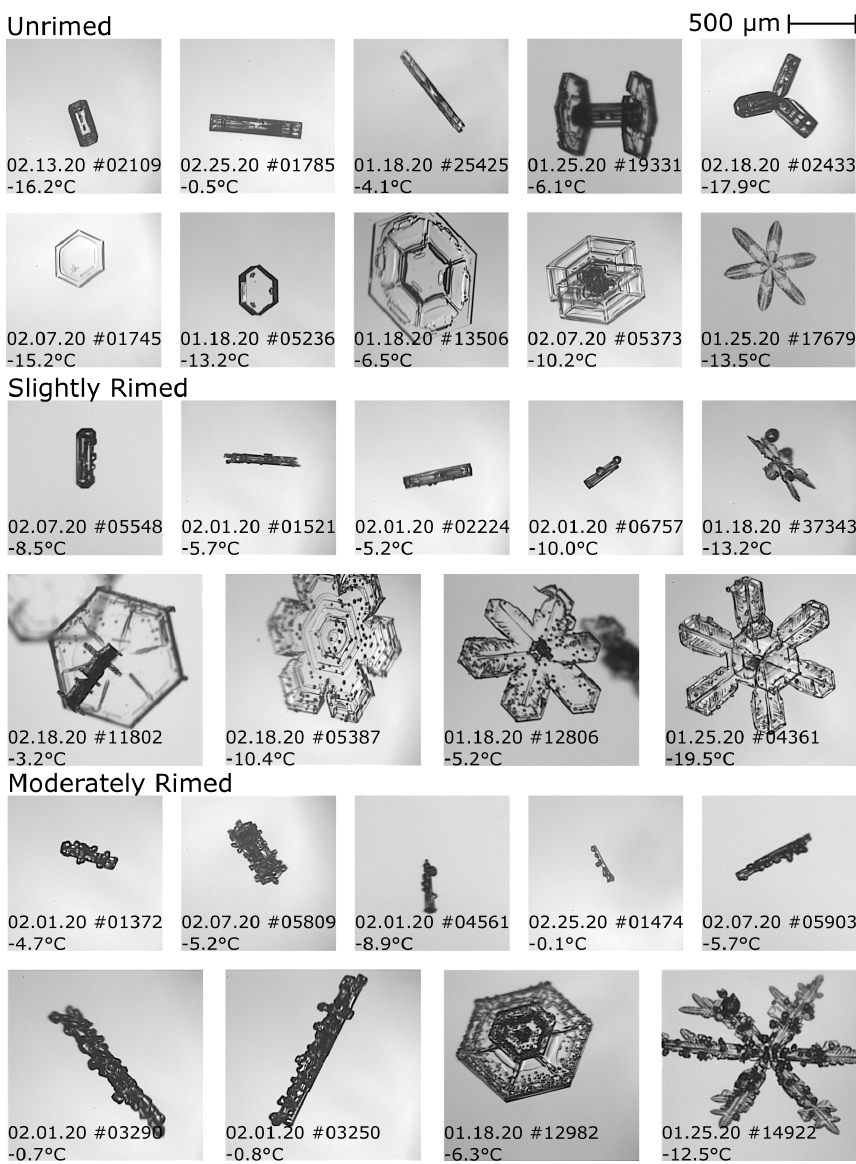
Figure 2. Examples of representative PHIPS particles with different degrees of riming categorized by the surface riming degree (SRD): unrimed (SRD = 0%), slightly rimed (0% < SRD < 25%) and moderately rimed (25 ≤ SRD ≤ 50%) particles. Heavily rimed (50% < SRD < 100%) and graupel particles (SRD = 100%) are shown in Fig.